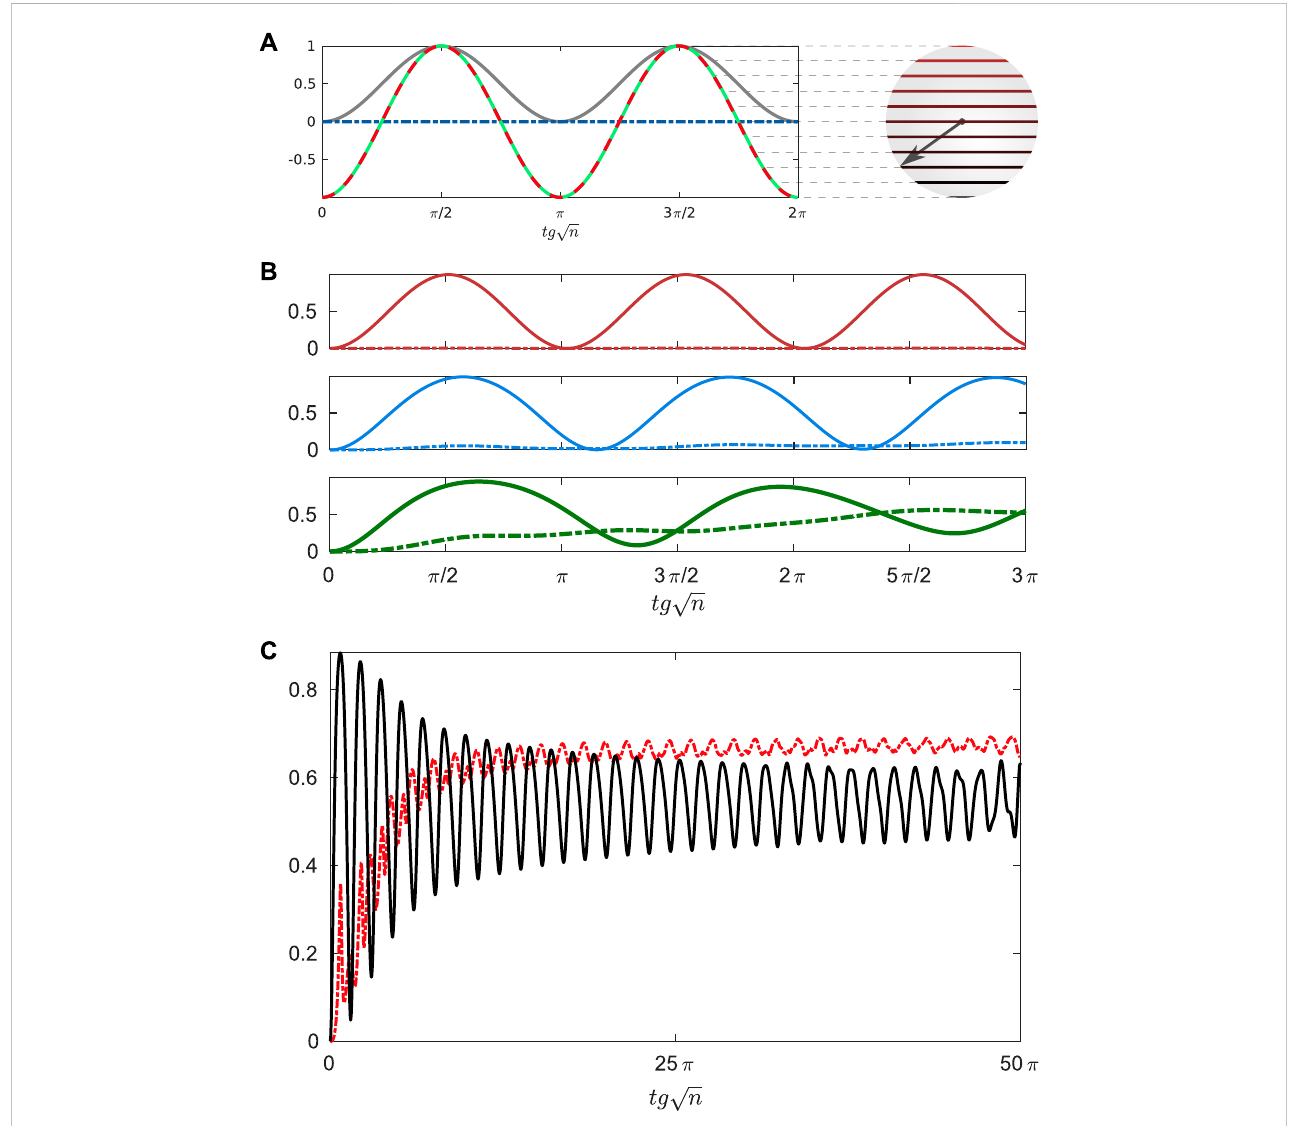
FIGURE 3 (A) The evolution of 10 spins under the 10 4 cavity driving photons with the charging Hamiltonian Eq. 8. The gray curve stands for the energy deposited (indimensionlessunits),whichevolvesperiodicallyasthespinsareconsistently fl ippedfromdowntoupandvice-versa.WetaketheVon intoeachbattery W ( t ) N ω a Neumannentropy of the fi rst spin from reduced density matrix as a measure for the amount of entanglementof thebatteries. This indicator (blue dotted line) stays0meaningthatthereisnoentanglementbeingcreatedduringtheprocess.Theoverlappinggreenandredcurvesdepicttheevolutionofcos θ j ,with 〈 (cid:2) s 〉 and the z + axis for the j th spin (shown as the right sphere). Here the red curve stands for the fi rst spin, i.e., j =1 and the green one θ j j the angle between represents foranotherrandomlypickedspinout ofthebatteries. Thisoverlap meansall spinsinthecavity evolveexactly instep. (B) Fromtop tobottomthese three subplots indicate the charging of 10 spins with 100, 20, and 12 photons respectively. As before, solid curves refer to the deposited energy on each spin and the dotted line stands for the amount of entanglement. As the number of cavity photons shrinks, entanglement shows up and the spins cannot be fully charged.Sucharesultsuggeststhattherequirementof N / n ≪ 1canbereachedaslongasthephotonsoutnumberthespinsbyanorderofmagnitude. (C) The supplementary plot for the evolution of 100 spins driven by 90 photons. As time progresses, dynamical equilibrium between the photons and spins will be formed as indicated in Ref.